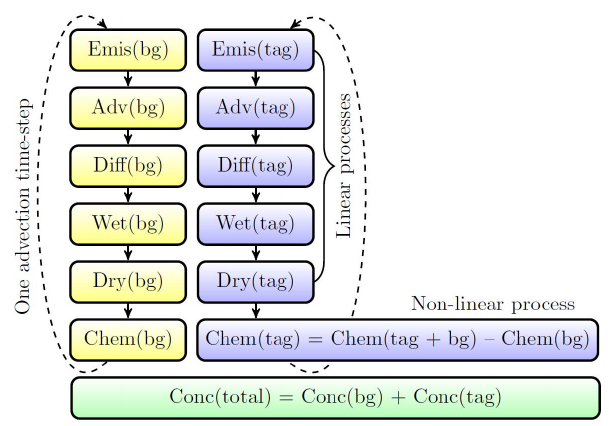
Fig. 3. An overview of the tagging method. The concentration field for a specific emission source (tag) is modelled in parallel with the background field (bg) in the CTM. The need for tagging is due to the non-linear process of atmospheric chemistry (Chem). The linear processes are emissions (Emis), advection (Adv), atmospheric dif- fusion (Diff), wet deposition (Wet), and dry deposition (Dry). For the non-linear process, the tagged concentration fields are estimated by first adding the background and tag concentration fields, then ap- plying the non-linear operator (e.g. the chemistry). The concentra- tion field obtained by applying the non-linear operator to the back- ground field alone is then subtracted. Thus the contribution from the specific emission source is accounted for appropriately without assuming linearity of the non-linear atmospheric